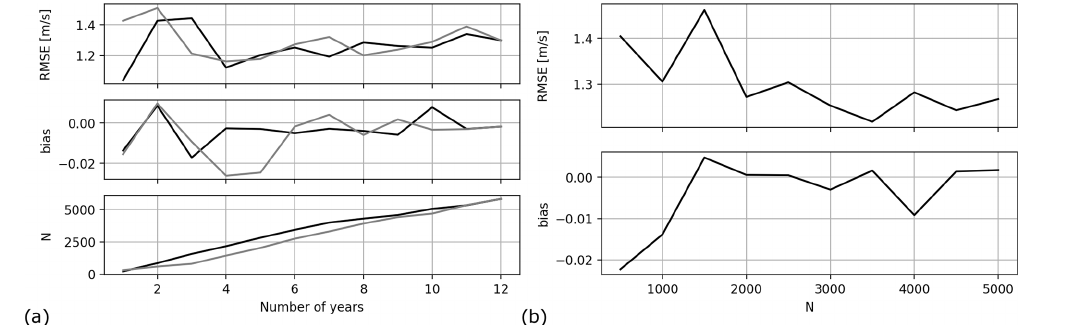
Figure 8. Metric evolution by an incremental number of samples used to train the RFM. (a) Lowest RMSE for individual years trained sequentially (black lines) and sequential training by year from 2010–2021 (grey lines). (b) Training-averaged cumulative random samples of the total dataset.